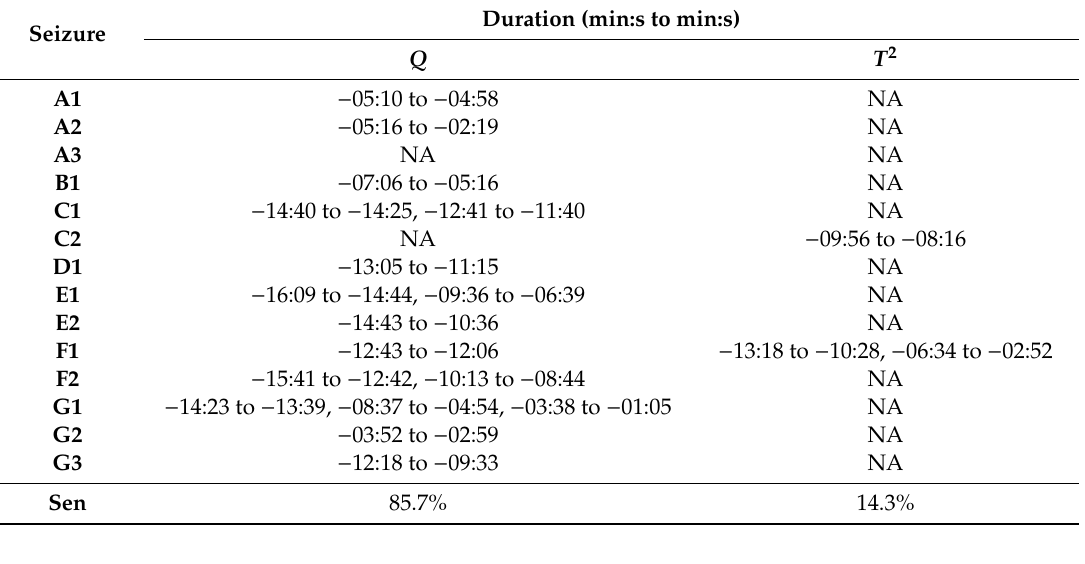
Table 4. Seizure prediction performance. The duration of prediction is shown with the start and the end of exceedance (e.g., − 05:28 to − 05:17) means that the statistic exceeded the control limit from 5 min 28 sec to 5 min 17 sec prior to a seizure. NA indicates not available, meaning that the statistic did not exceed the control limit. Sen (sensitivity) summarizes the true positive ratio of seizure prediction.